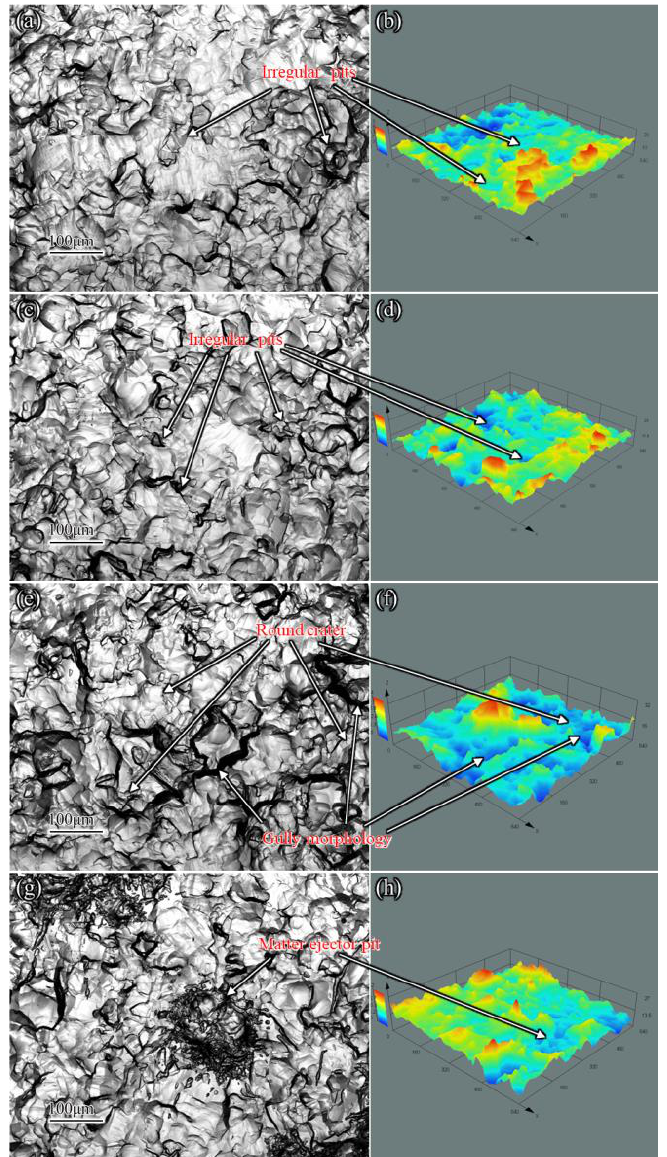
Figure 5. 2D and 3D microscopic topography of Cu target surface under different currents: ( a , b ) 2 A, ( c , d ) 8 A, ( e , f ) 13 A, and ( g , h ) 18 A.